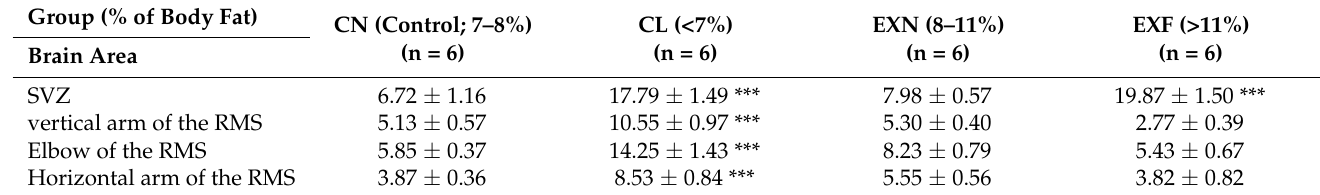
Table 3. The number of FJC+ cells in the SVZ/RMS neurogenic region (200 µ m × 200 µ m area) in mice with various body conditions. Abbreviations: SVZ—subventricular zone; RMS—rostral migratory stream; (CN) control group of mice characterized by normal weight and physiological percentage of body fat deposits; (CL) control group of mice characterized by reduced weight and reduced body fat deposits; (EXN) experimental group of mice characterized by normal weight and moderately elevated body fat deposits; (EXF) experimental group of mice characterized by markedly elevated weight and body fat deposits. Data are shown as mean ± SEM. Statistical significance of differences between experimental and control groups: *** p ≤